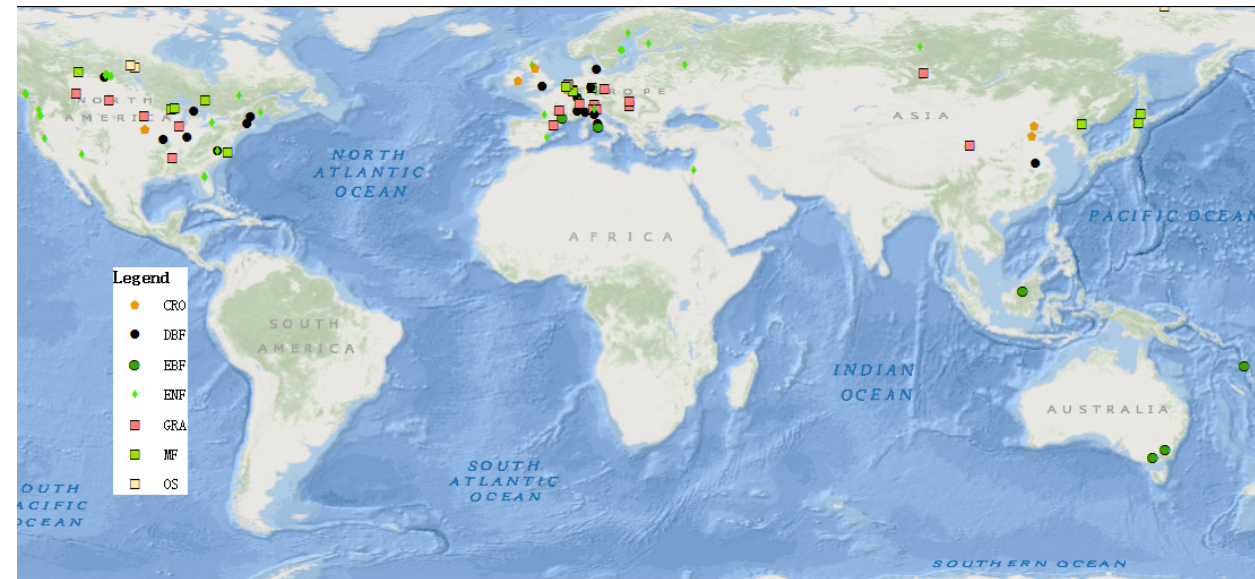
Figure 1. Location of eddy flux sites from which climate and evapotranspiration data are collected.